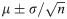
Bacterial population size for control bead and inhibitor treated rats in the experimental model.The discs and squares show the mean bacterial population size in control bead (n = 9 animals) and inhibitor (n = 13 animals) treated rats respectively, while the shaded regions show the standard error of the mean (that is, μ±σ/n, where μ is the mean and σ is the standard deviation). Treatment with the inhibitor reduces, but does not eliminate, the bacterial burden. CFU: colony-forming units.